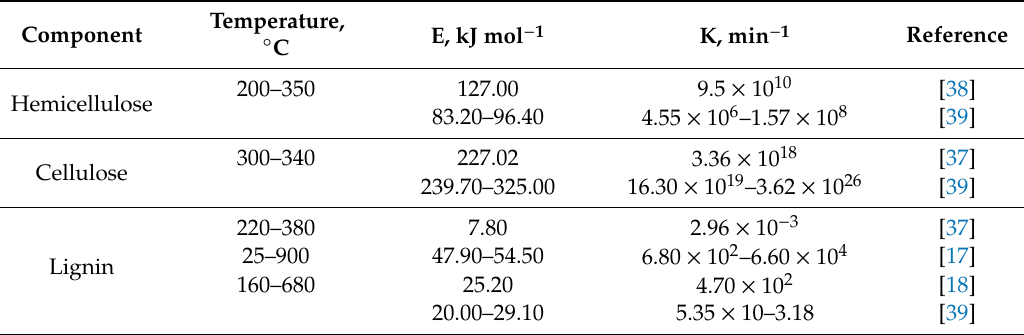
Table 7. Kinetic parameters from other